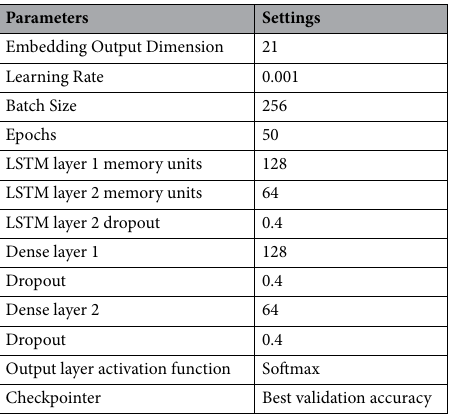
Table 3. Parameters description of LSTM model with embedding